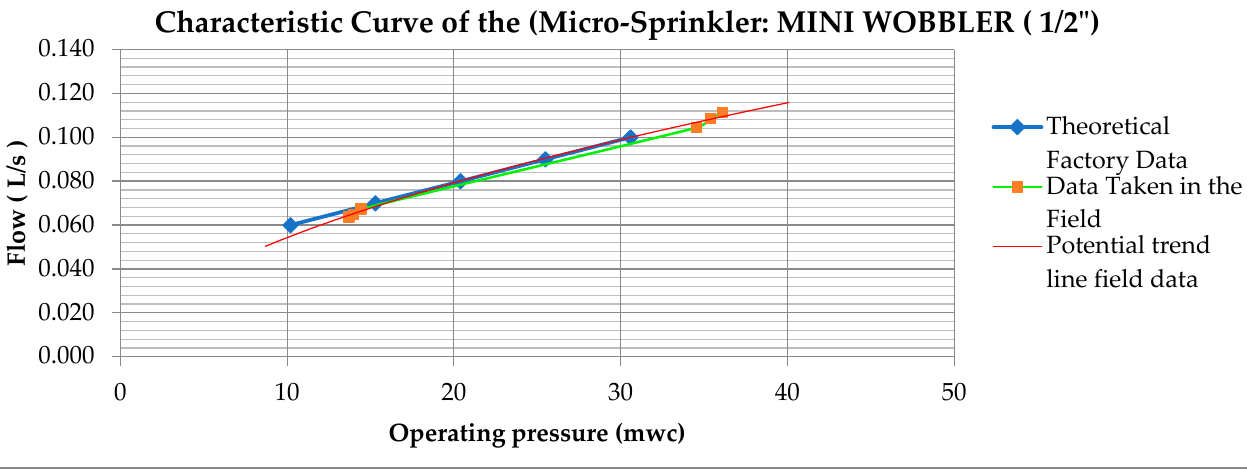
Figure 4. Comparison of characteristic curve of Mini Wobbler micro-sprinkler (factory and field data).